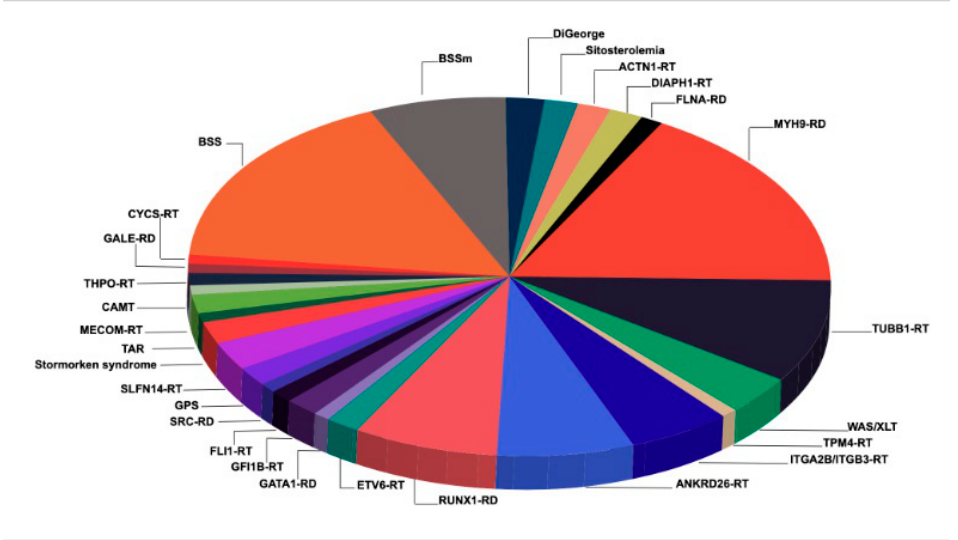
Figure 1. Percentages of patients with inherited thrombocytopenias, with a confirmed molecular diagnosis, identified among 114 families in Spain. Abbreviation: RT: related thrombocytopenia: RD: related disorder; BSS: Bernard − Soulier syndrome; m: monoallelic; TAR: thrombocytopenia absent radii; CAMT: congenital amegakaryocytic thrombocytopenia; GPS: gray platelet syndrome; WAS/XLT: Wisko tt− Aldrich syndrome/X-linked thrombocytopenia.